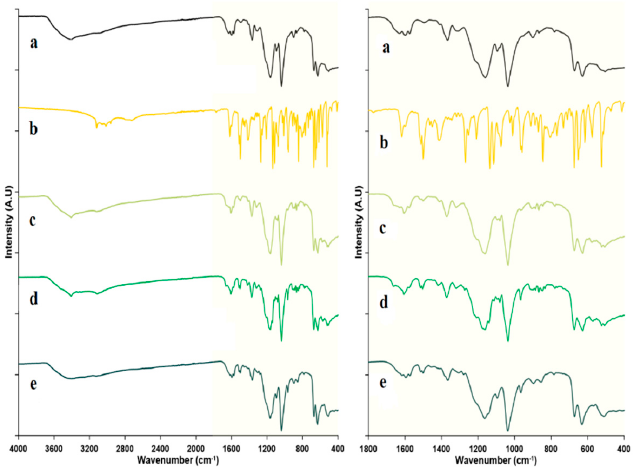
Figure 6. FT-IR spectra for: ( a ) Sulfonatocalix[4]naphthalene, ( b ) fluconazole (FZ) ( c ). Physical mixture (PM) ( d ). Kneaded (KN) and ( e ) co-evaporate powder (CO).